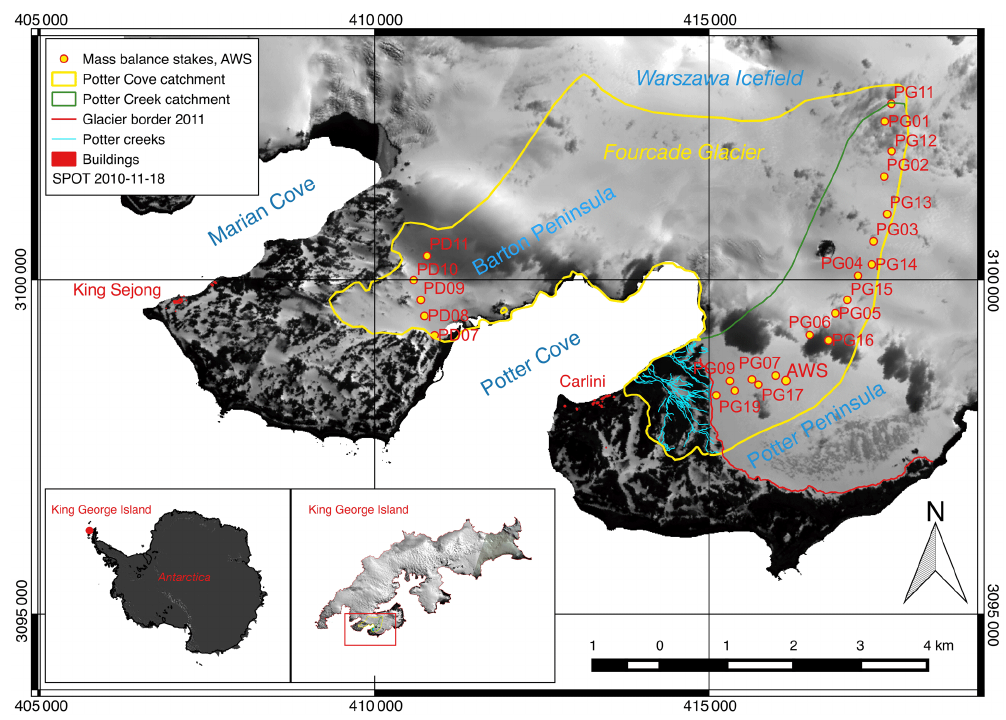
Figure 1. Map of research area on King George Island (South Shetland Islands, northern Antarctic Peninsula) including the locations of our own installations and external data time series. Potter creek basins of Potter North and Potter South with drainage channels and mass balance stake locations along two transects, PG0 x and PG1 x (where x is a placeholder for stake number), in the catchment area. Background: SPOT-4, 18 November 2010, © ESA TPM,